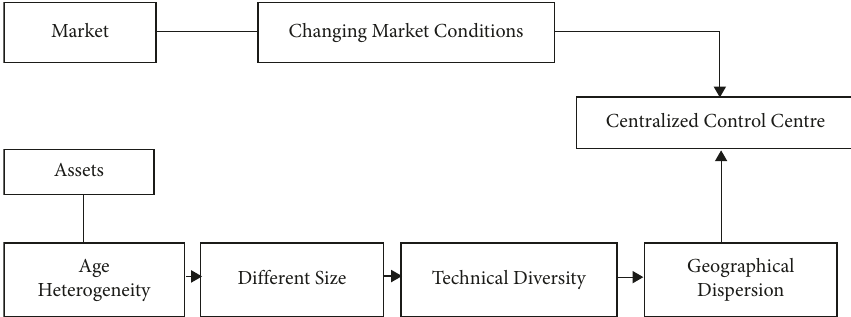
Figure 4: Advanced technologies in hybrid-renewable-energy system (HRES).